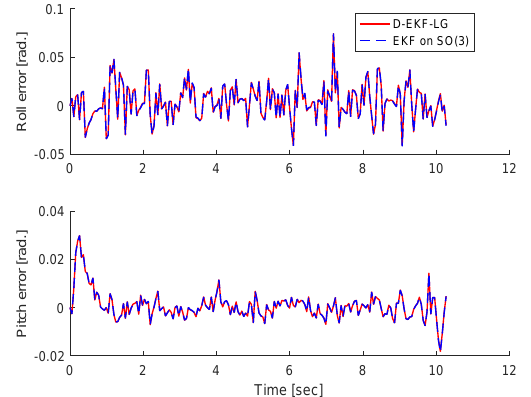
Figure 11: The D-EKF-LG and the proposed EKF on SO (3) have no distinct differences when inter- preting the given data sets, which in this particu- lar case is the error plot from the pitch case from both of the estimators.